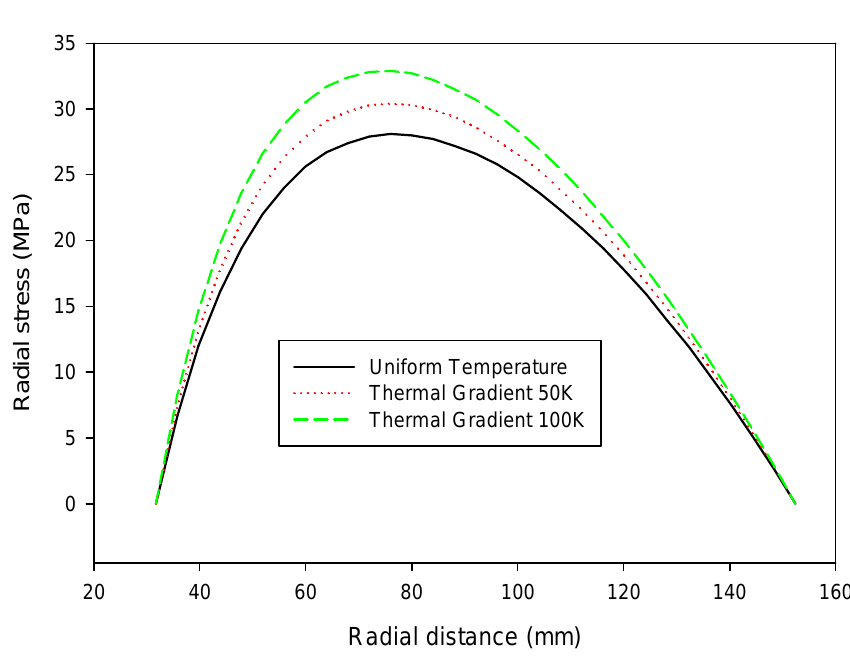
Figure 1. Variation of radial stress along the radial distance with composite disc with/without thermal